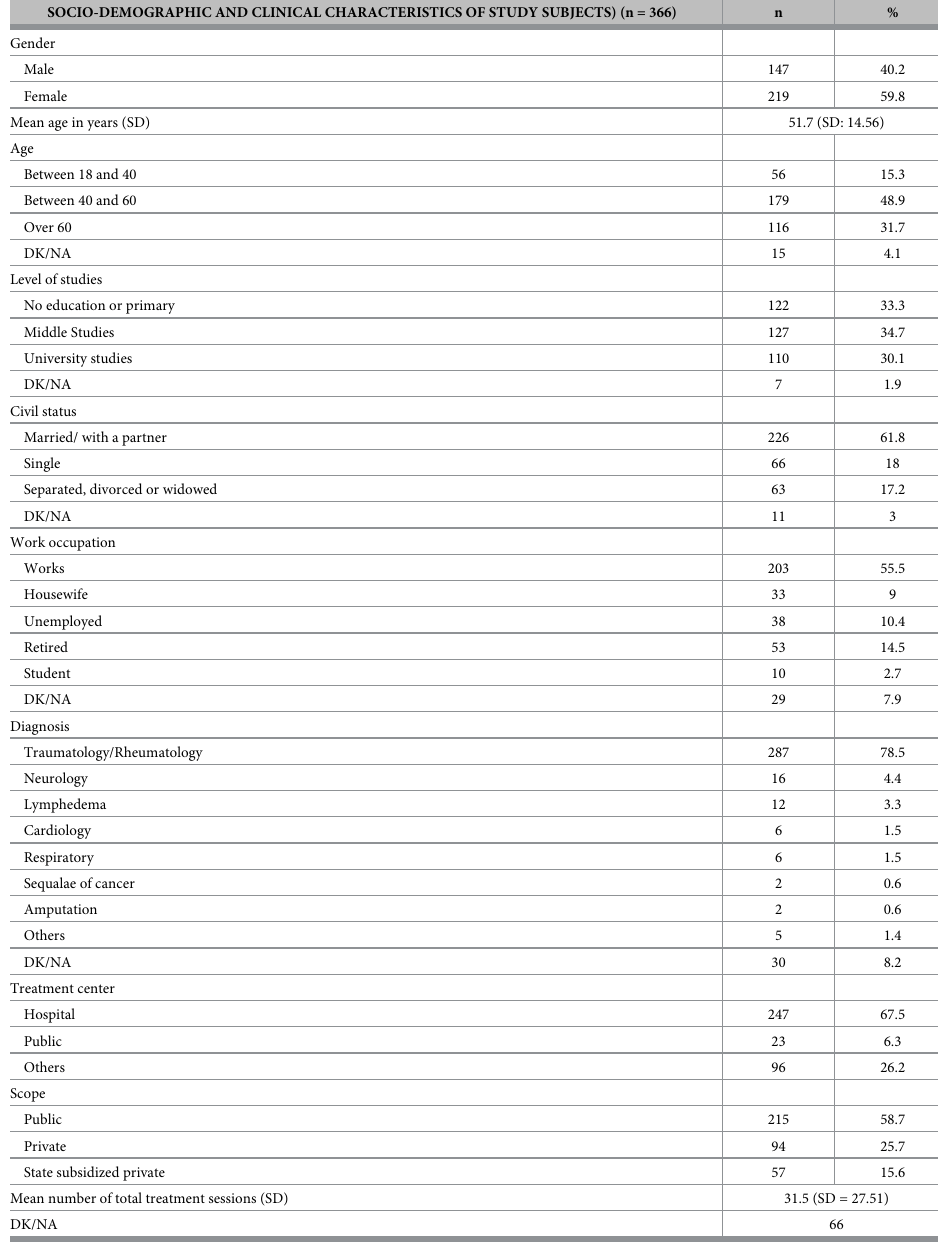
Table 1. Socio-demographic and clinical characteristics of the study subjects (n = 366). SOCIO-DEMOGRAPHICANDCLINICALCHARACTERISTICSOFSTUDYSUBJECTS)(n=366) n